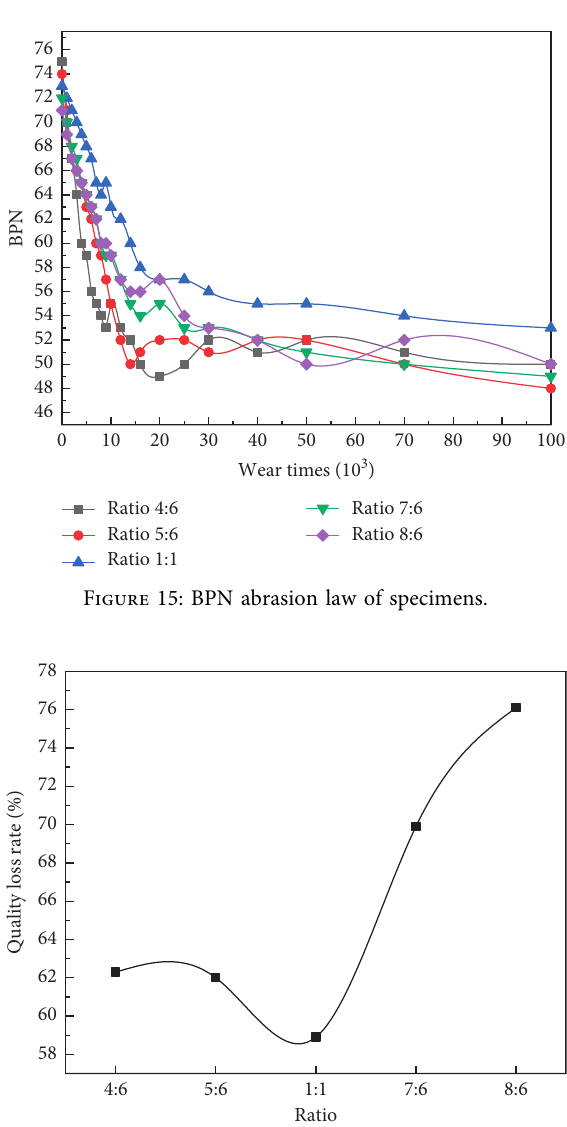
Figure 16: Mass loss rate of